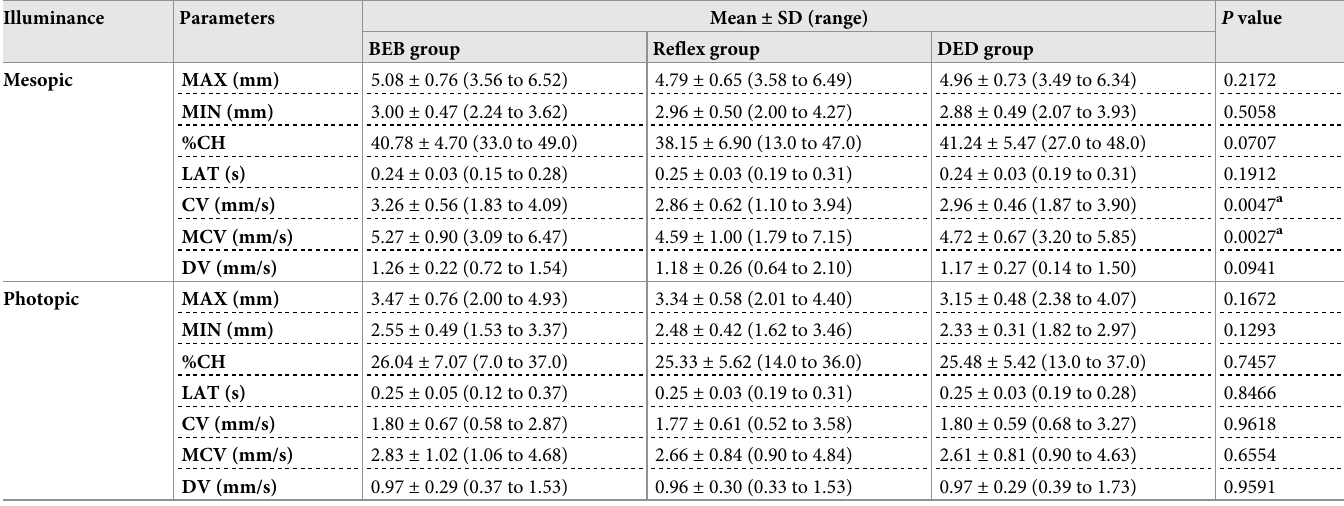
Table 3. The pupillary light reflex-related parameters in patients with benign essential blepharospasm and reflex blepharospasm. Illuminance